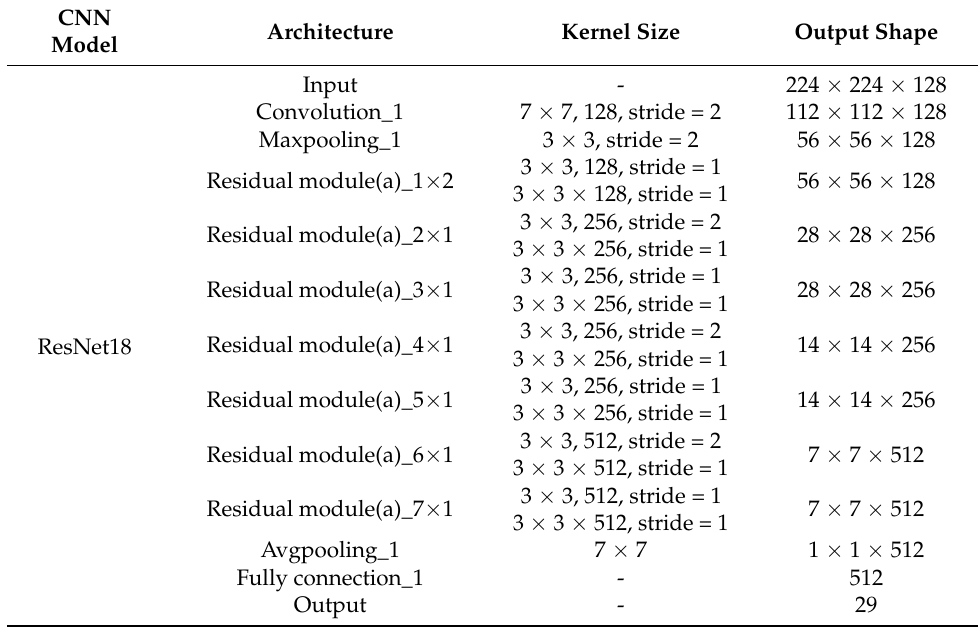
Table 3. The architecture of the ResNet18 and